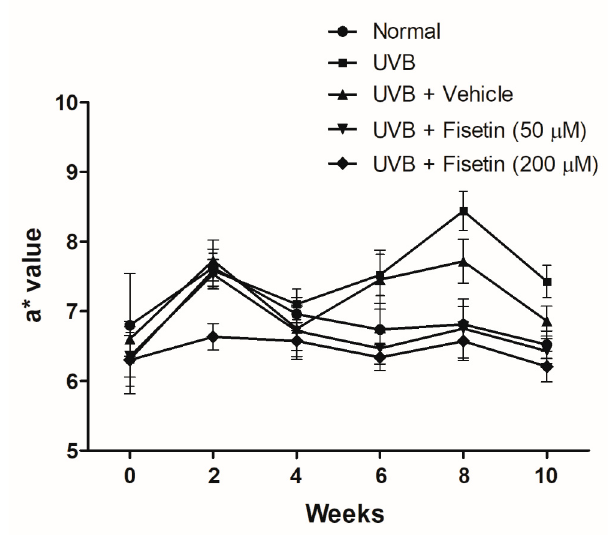
Figure 2. Effects of fisetin on the a* values in the UVB-irradiated hairless mice.